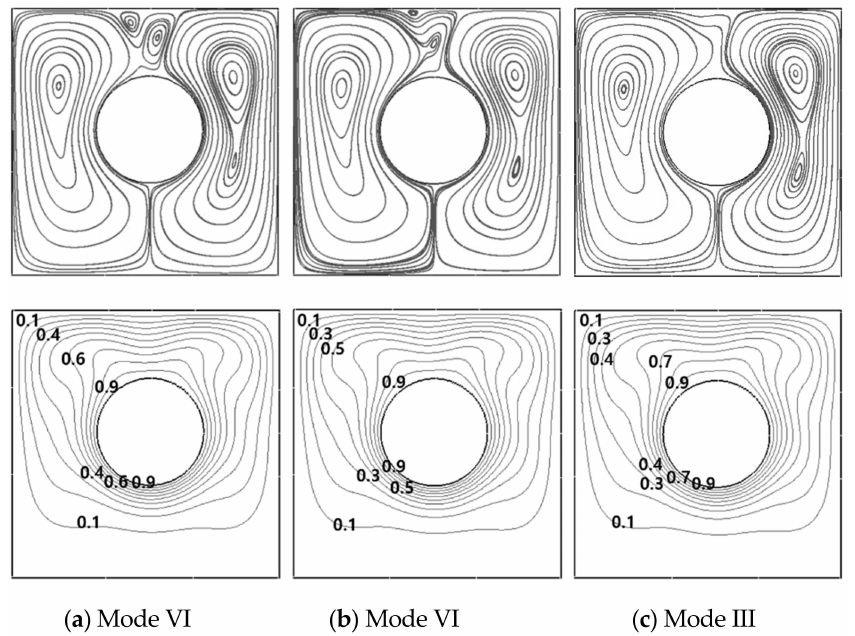
Figure 15. Streamlines (upper row) and isotherms (lower row) at ( a ) θ = 70 ◦ , ( b ) θ = 60 ◦ and ( c ) θ = 50 ◦ at a fixed r = 0.05 L for Ra = 10 5